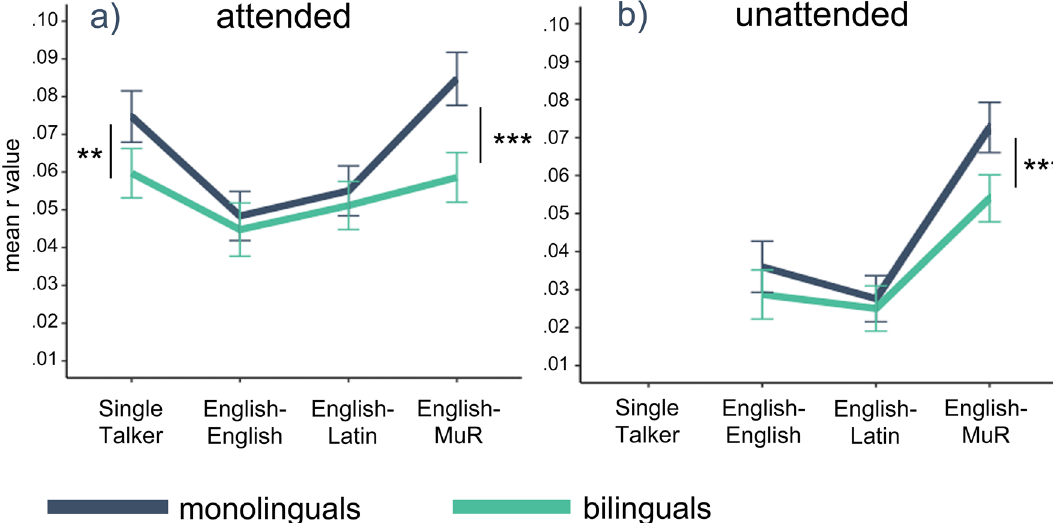
Figure 3. Between-group differences in reconstruction accuracy scores per condition. Summary of the pattern of results for ( a ) attended streams, and ( b ) unattended streams. Error bars represent 95%